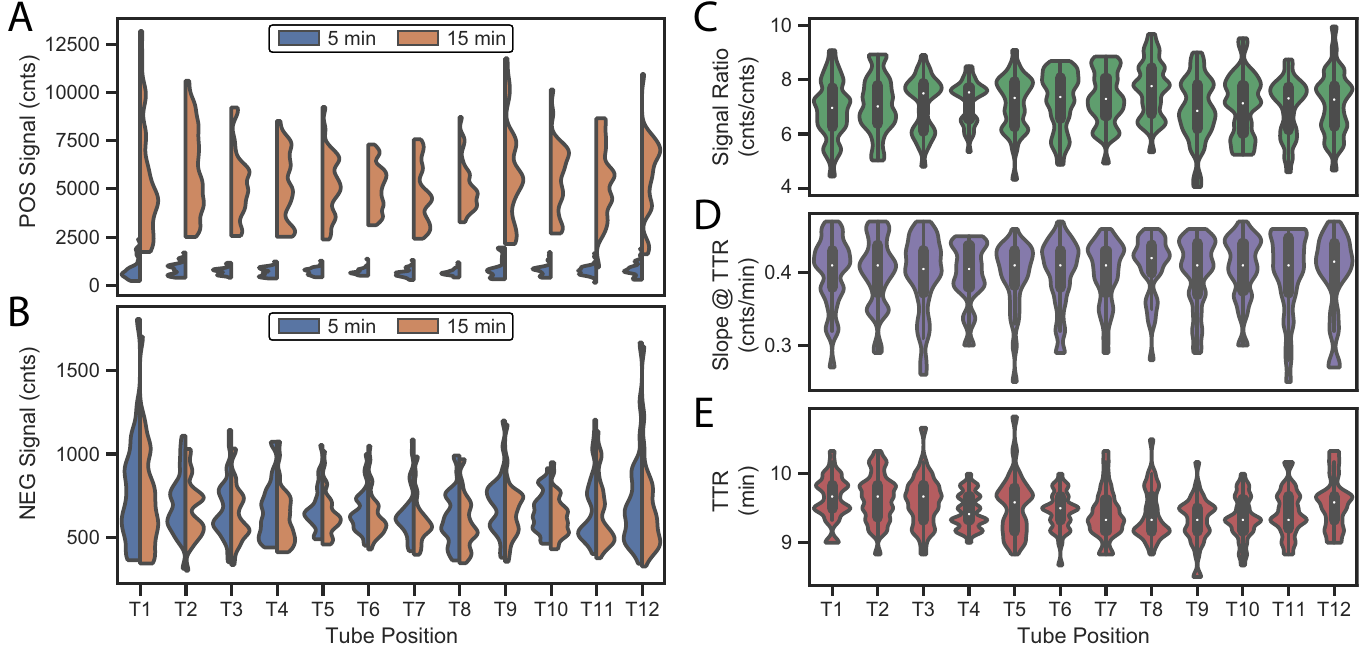
Fig 7. Tube-to-tube variability. (A) Signal amplitudes for positive assays across all tube positions at t = 5 min (before amplification) and t = 15 min (after amplification). (B) Signal amplitudes for a negative assay at the same timepoints. (C) Ratios of signals for positive assays at t = 15 min to signals at t = 5 min all tube positions. (D) Signal slope at TTR for positive assays across all tube positions. (E) TTR for positive assays across all tube positions.